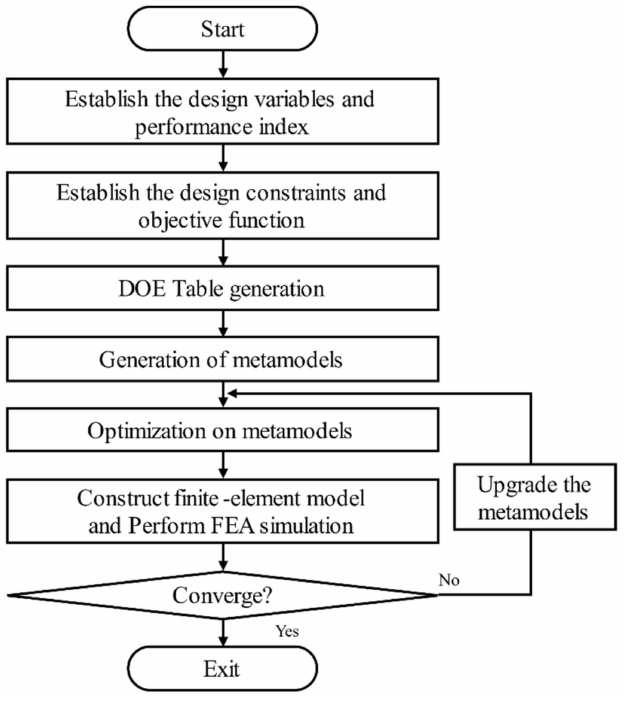
Figure 13. Sequential approximate optimization process based on progressive meta